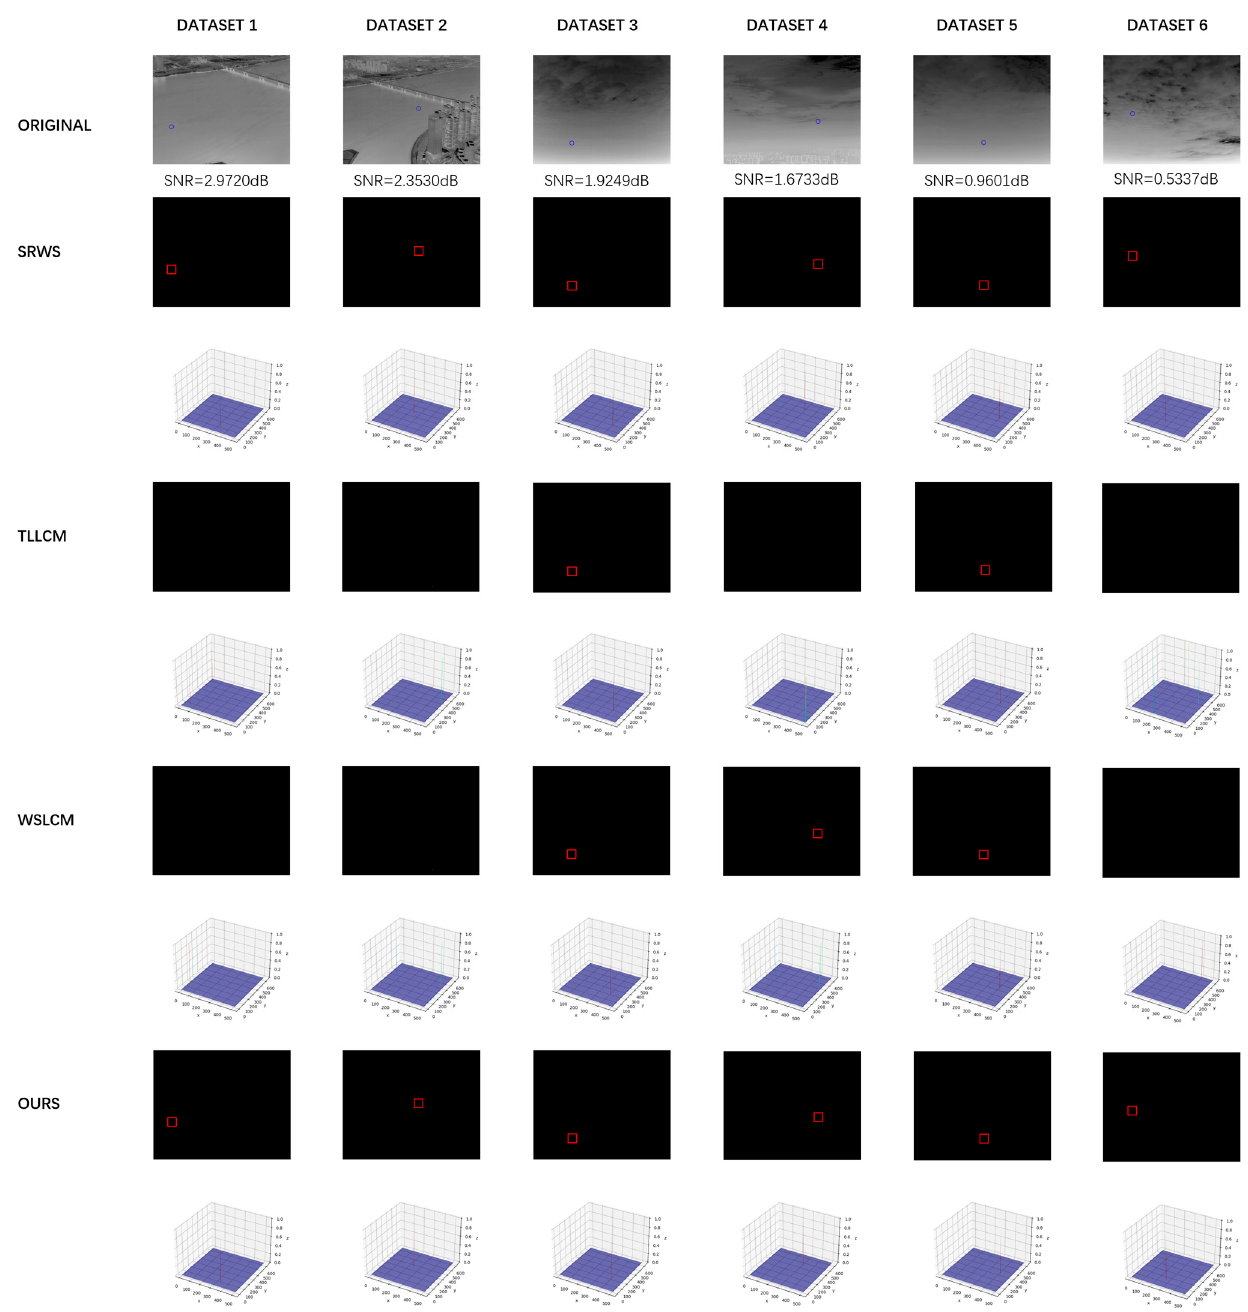
Figure 18. Resulting diagrams from the comparison experiment: SRWS, TLLCM, WSLCM, and Our method.